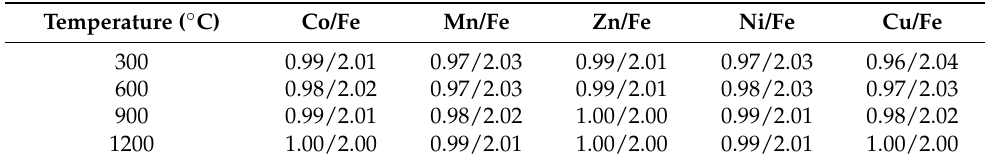
Table 1. M/Fe molar ratio in the MFe 2 O 4 @SiO 2 (M = Co, Cu, Mn, Ni, Zn) annealed at 300, 600, 900, and 1200 ◦